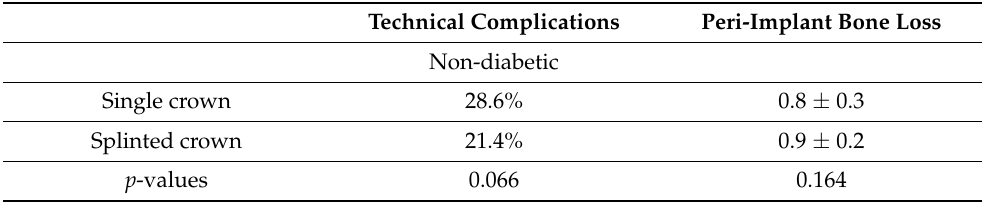
Table 5. Influence of type of prostheses on technical complications and peri-implant bone